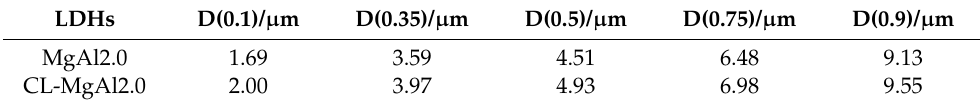
Figure 11. Particle size distribution (dry method) of MgAl2.0 and its crosslinked counterpart CL- MgAl2.0. Table 4. Particle size (dry method) of MgAl2.0 and its crosslinked counterpart CL-MgAl2.0.